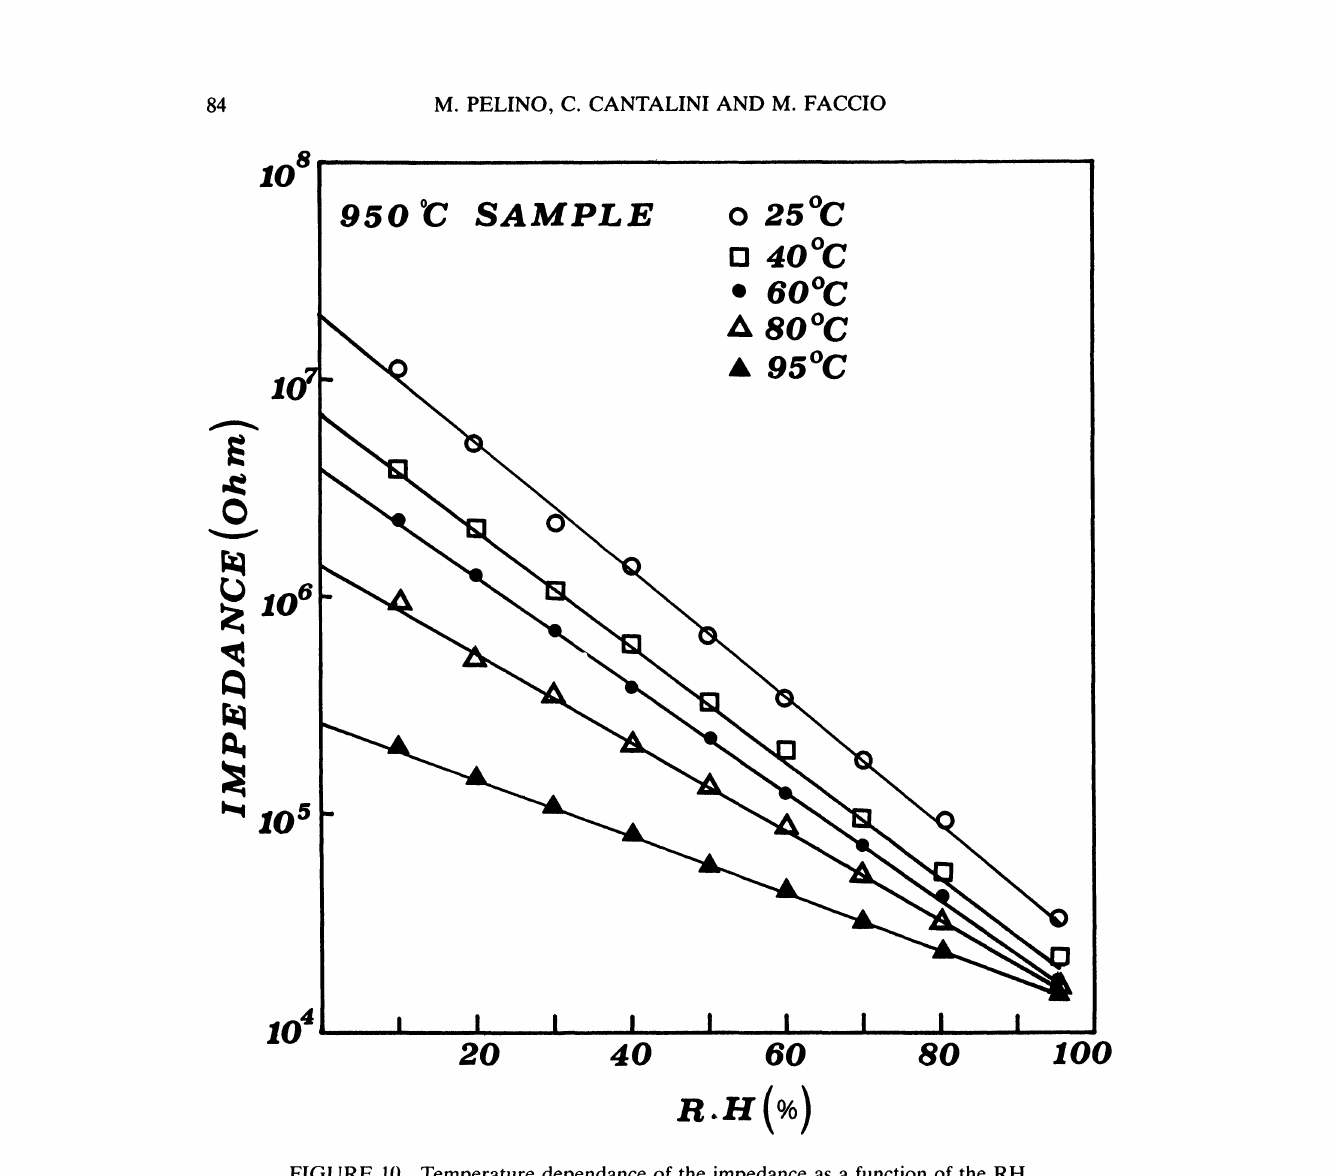
FIGURE 10 Temperature dependance of the impedance as a function of the